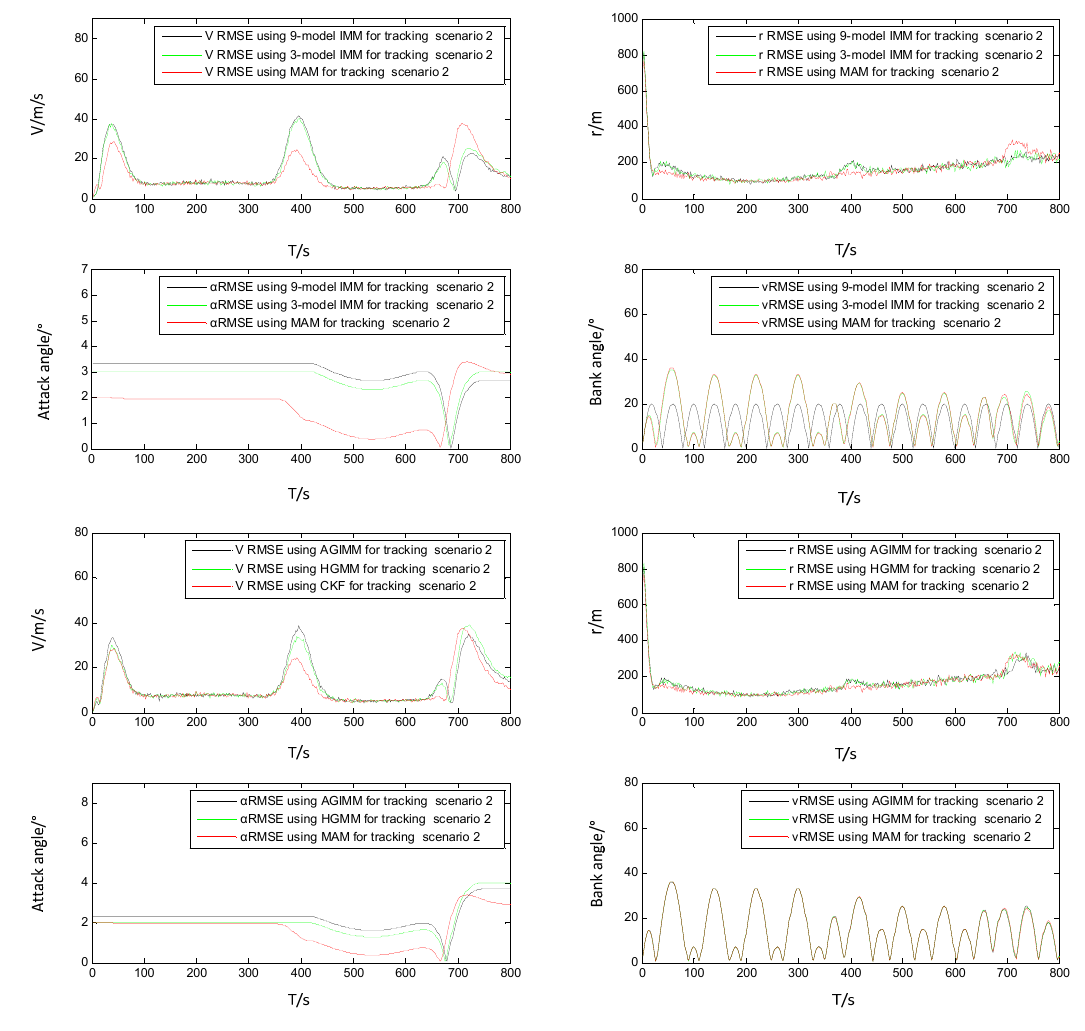
Figure 3. RMSE for tracking Scenario 2. Table 1. The performances for stably tracking Scenario 1.